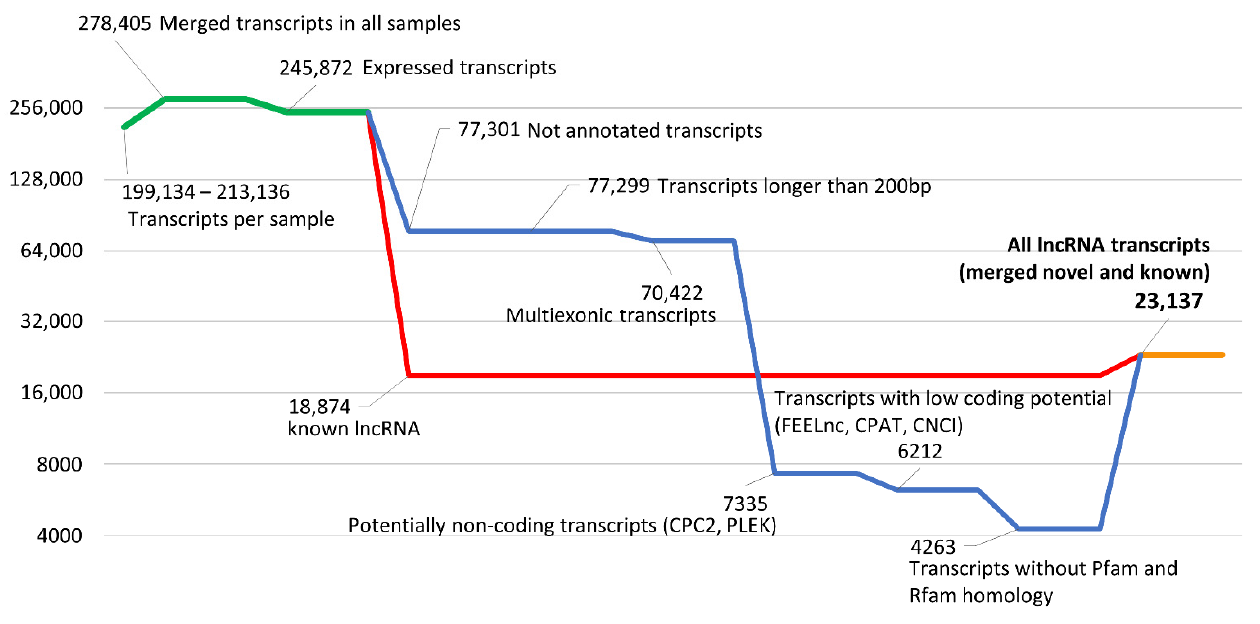
Figure 2. The stages of the lncRNA identification process. The Y-axis shows the number of transcripts in log 2 scale. The green line presents all the transcripts merged from all samples. The red line describes the number of all known (annotated in GENCODE) lncRNAs expressed in analyzed samples. The blue line shows the progress of lncRNA prediction. The orange line represents the sum of detected known and novel lncRNAs.